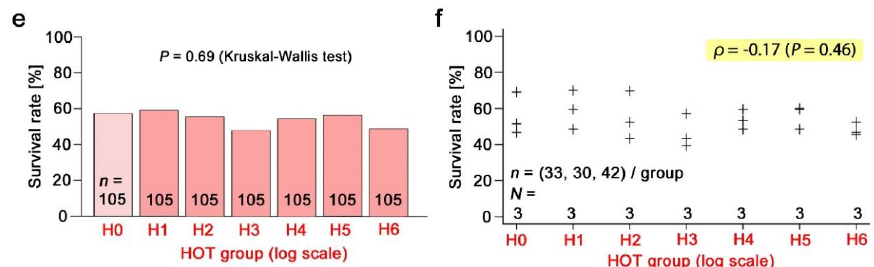
Figure 6. Effects of radioactive caesium chloride. In a, c, and e, all individual samples in the three trials were summed together, and the differences among the groups were examined using a Kruskal–Wallis test. In b, d, and f, the three trials were independently plotted, and a Spearman correlation analysis was performed. N indicates the number of groups. ( a,b ) The pupation rate (%). ( c,d ) The eclosion rate (%). ( e,f ) The survival rate (%). Insects 2019 , 10 , x